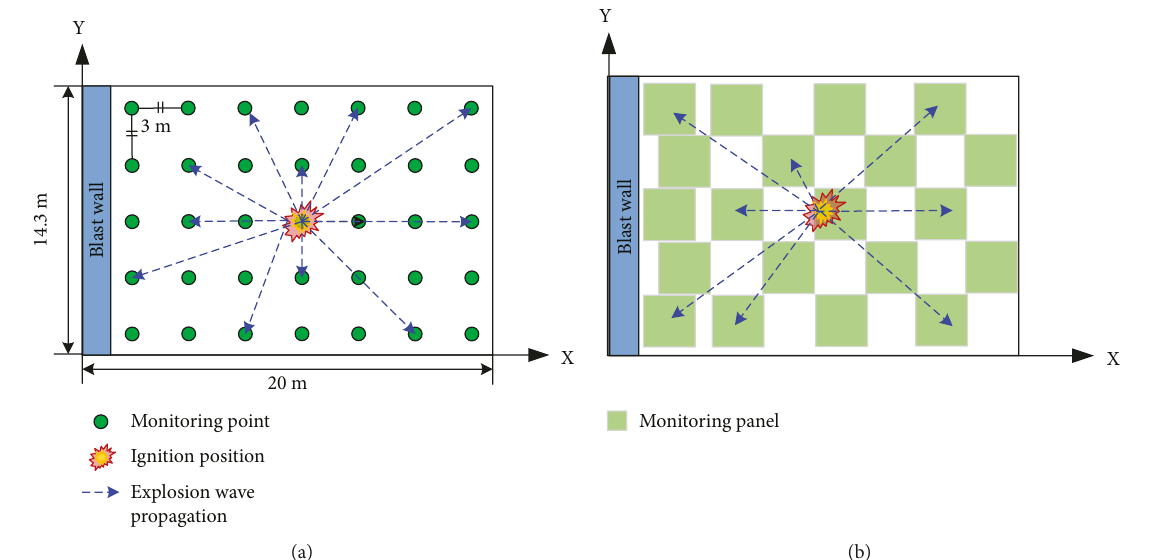
Figure 4: De fi nition of monitoring tools on the deck. (a) Monitoring point; (b) monitoring